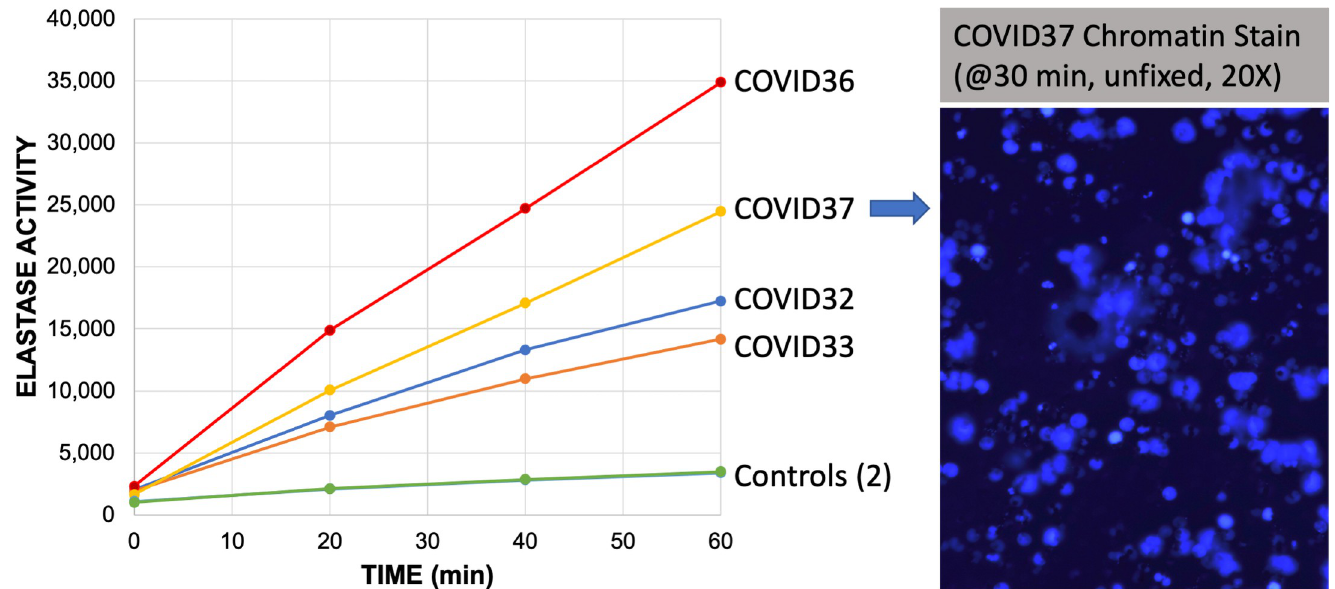
Fig 7. Neutrophil elastase activity of purified CD15+ neutrophils from control or COVID-19 patients. CD15+ neutrophils were purified from whole blood of patients or controls using antibody coated magnetic beads, which were then counted using a hemocytometer. The CD15+ neutrophils from the equivalent of 50 μ l of blood (250K-600K cells) were then freeze-thawed (5X) and assayed for elastase activity using a fluorometric substrate measured over time for 4 COVID-19 patients (i.e. COVID36, COVID37, etc.). Each point is a single measure of fluorescence at the specified times after adding substrate. Controls (n = 2) are essentially superimposed. In the right panel, parallel samples of CD15+ neutrophils were magnetically adhered to a glass slide in HBSS and allowed to attach for 30 min prior to staining with DAPI to image the DNA without fixation. Photomicrograph is stimulated at 375 nm and emission captured at 415–460 nm with a 20X objective.